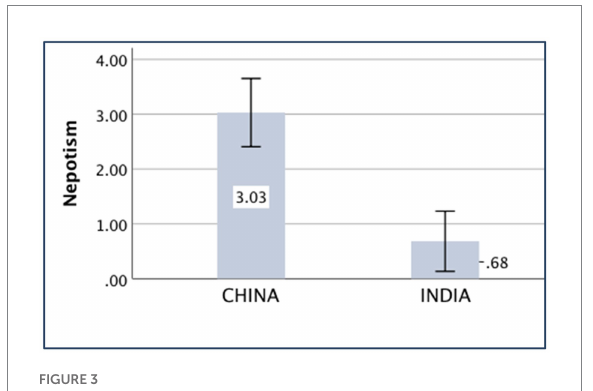
FIGURE 3 Nepotism of China and